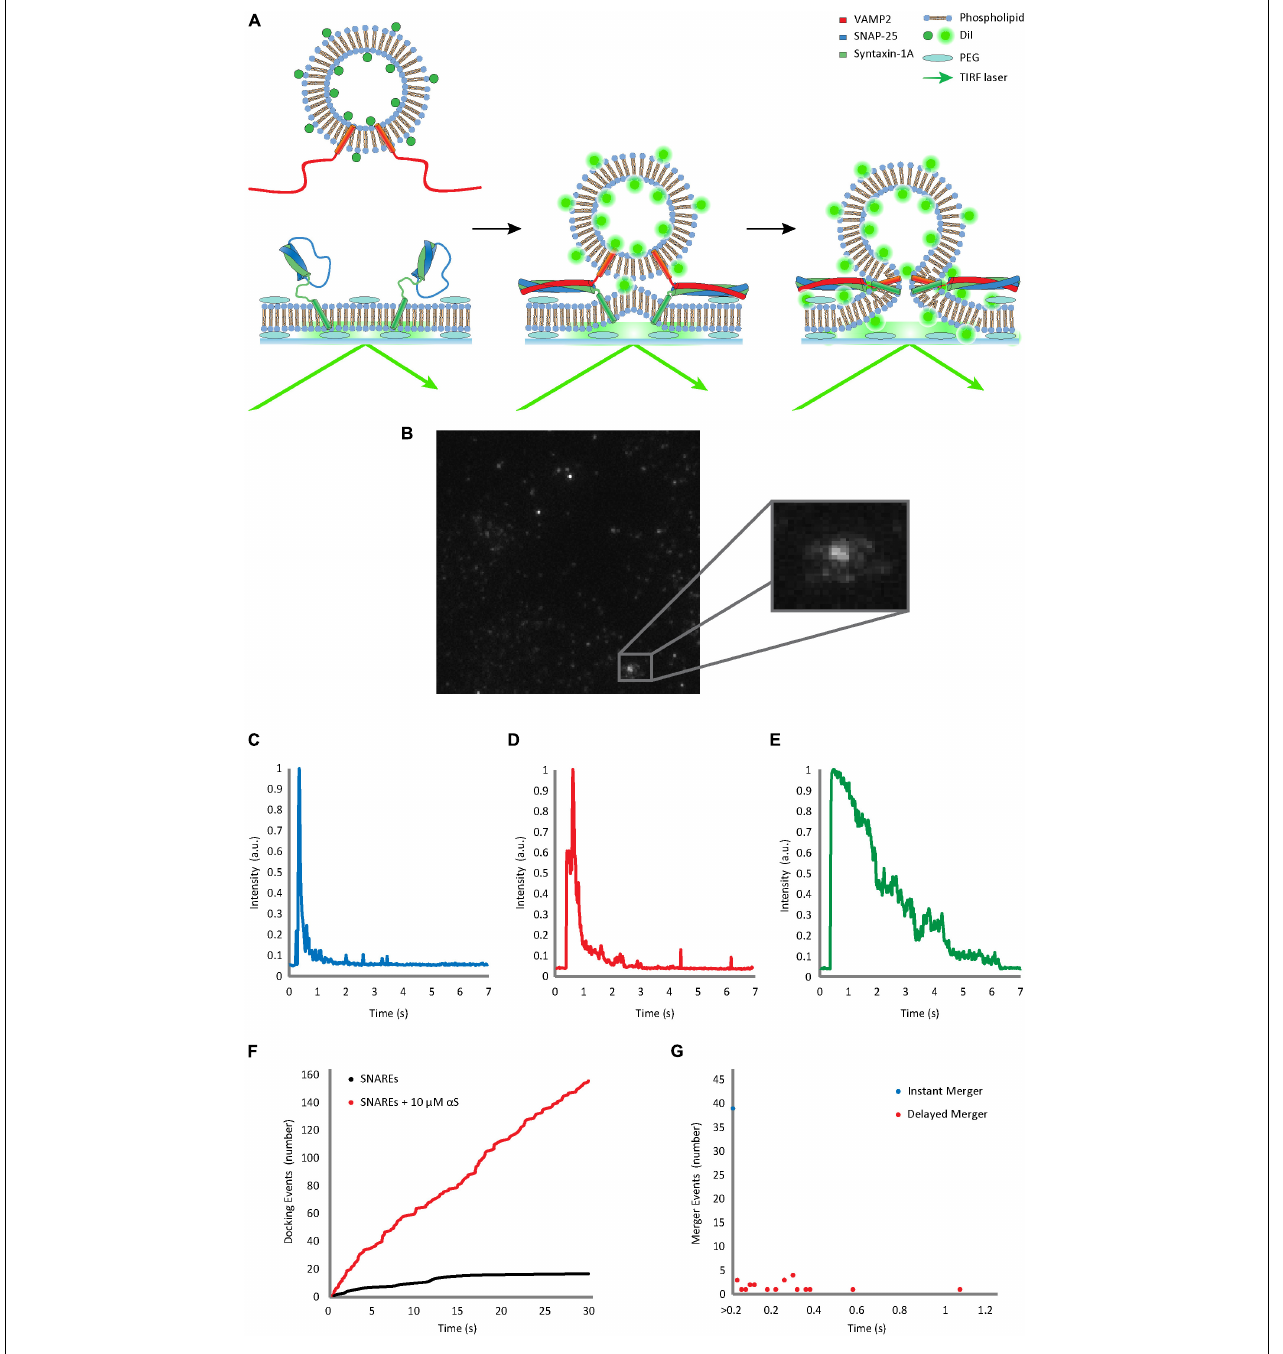
FIGURE 1 | Single vesicle-to-supported bilayer merger assay distinguishes vesicle docking from bilayer merger in real time. (A) Schematic diagram of the single vesicle-to-supported bilayer merger assay. V-vesicles are labeled with 1 mol % lipid-dye DiI. The t-bilayer is stabilized by a PEG (polyethylene glycol) cushion between the bilayer and the quartz slide. When v-vesicles dock onto the t-bilayer through SNARE zippering, the TIRF laser excites the fluorescent dye allowing the individual v-vesicle to be visualized. (B) Lipid diffusion on the bilayer surface due to bilayer merger. The large box contains a raw image of the docked and merging vesicles. The small box contains a zoomed image of lipid diffusion event. (C) Representative trace of the instant merger. (D) Representative trace of the delayed merger. (E) Representative trace of docking only. The fluorescence decay due to photo-bleaching is at least 5 times slower than the decrease due to lipid diffusion. Further classification of instant merger, delayed merger, and docking only events are defined in the Materials and Methods section. (F) Representative cumulative plot of docking events occurring within a single viewing area for 30 s. The black line indicates cumulative docking events without α S. The red line indicates those with twice purified α S at 10 µ M. (G) Representative scatter plot of the delay from docking to bilayer merger. Bilayer merger events that occur within the first 20 ms after docking are classified as instant merger, whereas merger events that occur later are classified as delayed merger.